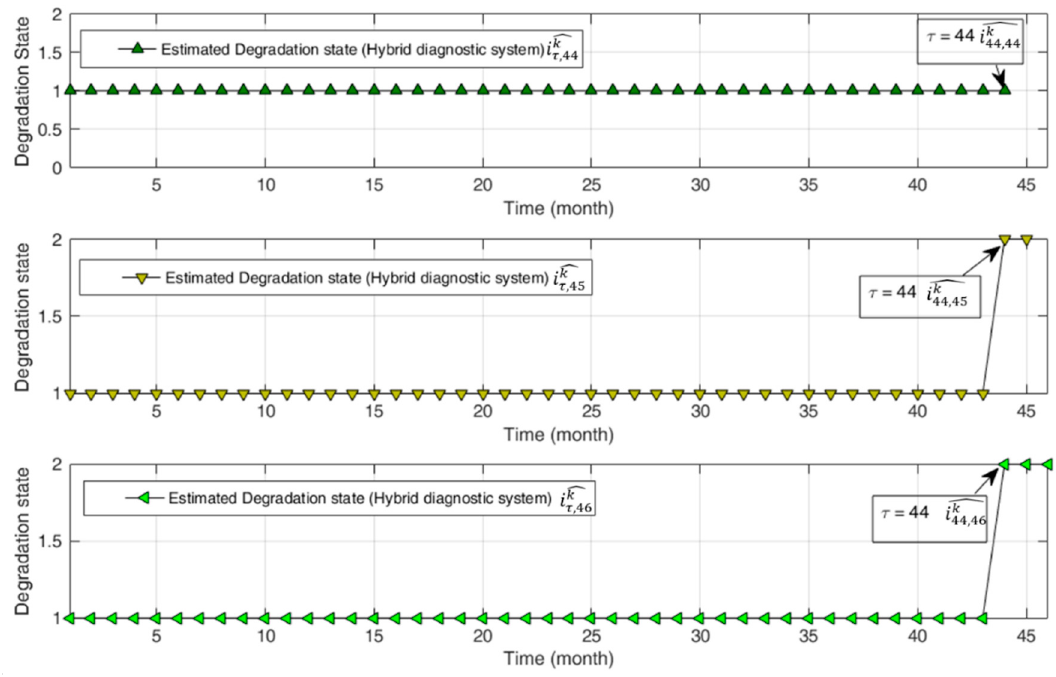
Figure 8. Estimate of the degradation state at time 𝜏 = 44 performed using the observation collected until time 𝑡 = 𝜏 = 44 ( top ), 𝑡 = 45 ( middle ), and 𝑡 = 46 ( bottom ). Notice that at time 𝑡 = 45 , the hybrid method is able to correctly classify the component state.